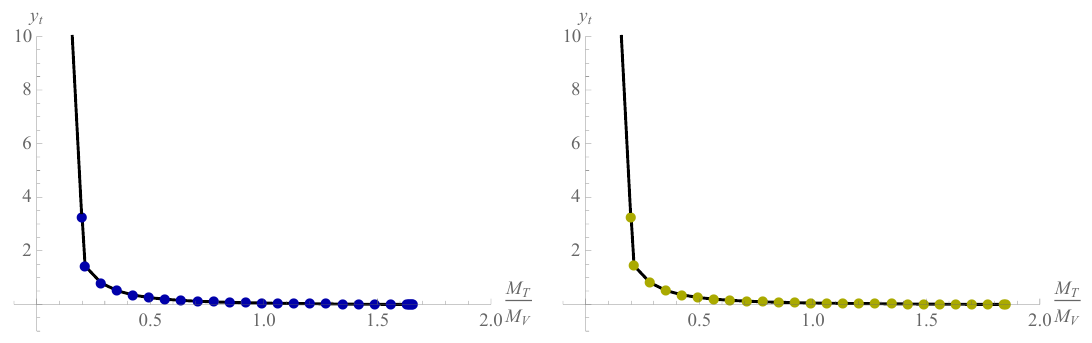
Figure 20. SU(4) 3 F, 3 ¯ F, 5 A 2 — The top Yukawa coupling, as given by (4.22), is plotted against the top partner mass units of the vector meson mass. M T is controlled by adding a HDO as in figure 13. We compute on the left with L 0 ( ρ ) for the fundamental quark and on the right we use the A 2 L 0 ( ρ )